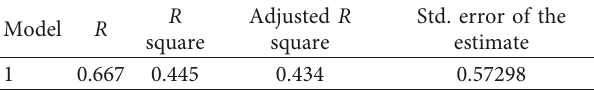
Table 5: Model summary.